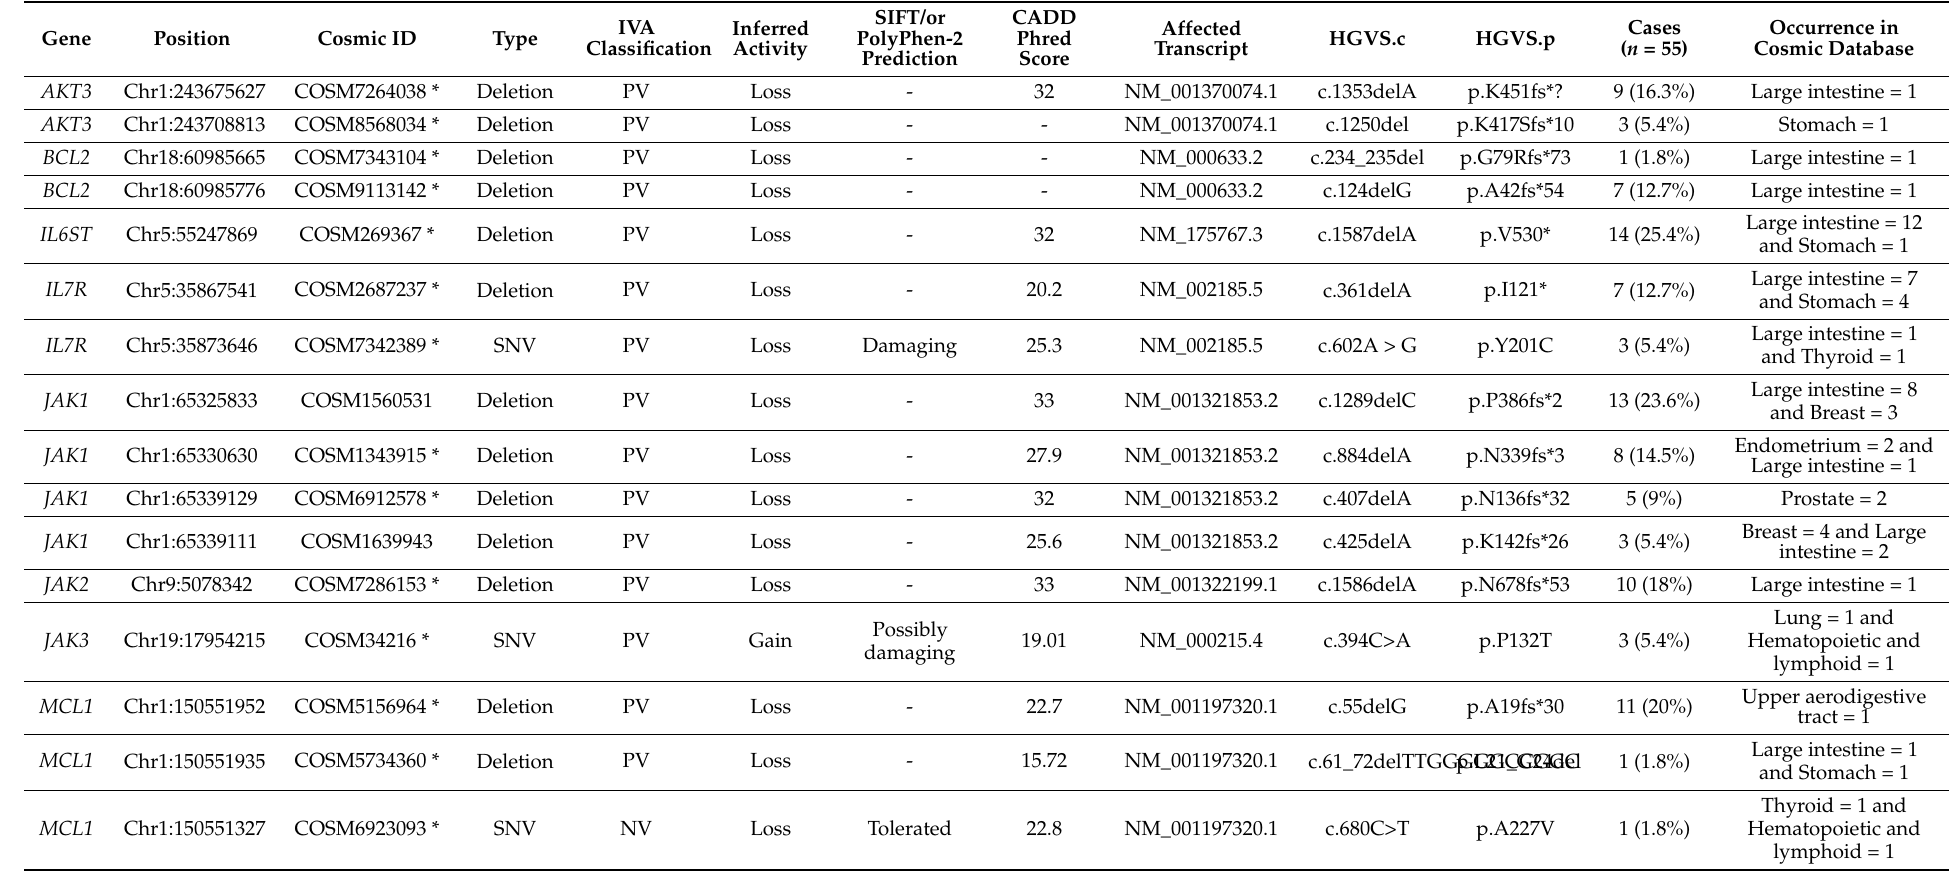
Table 2. Somatic mutations identified in our multigene panel